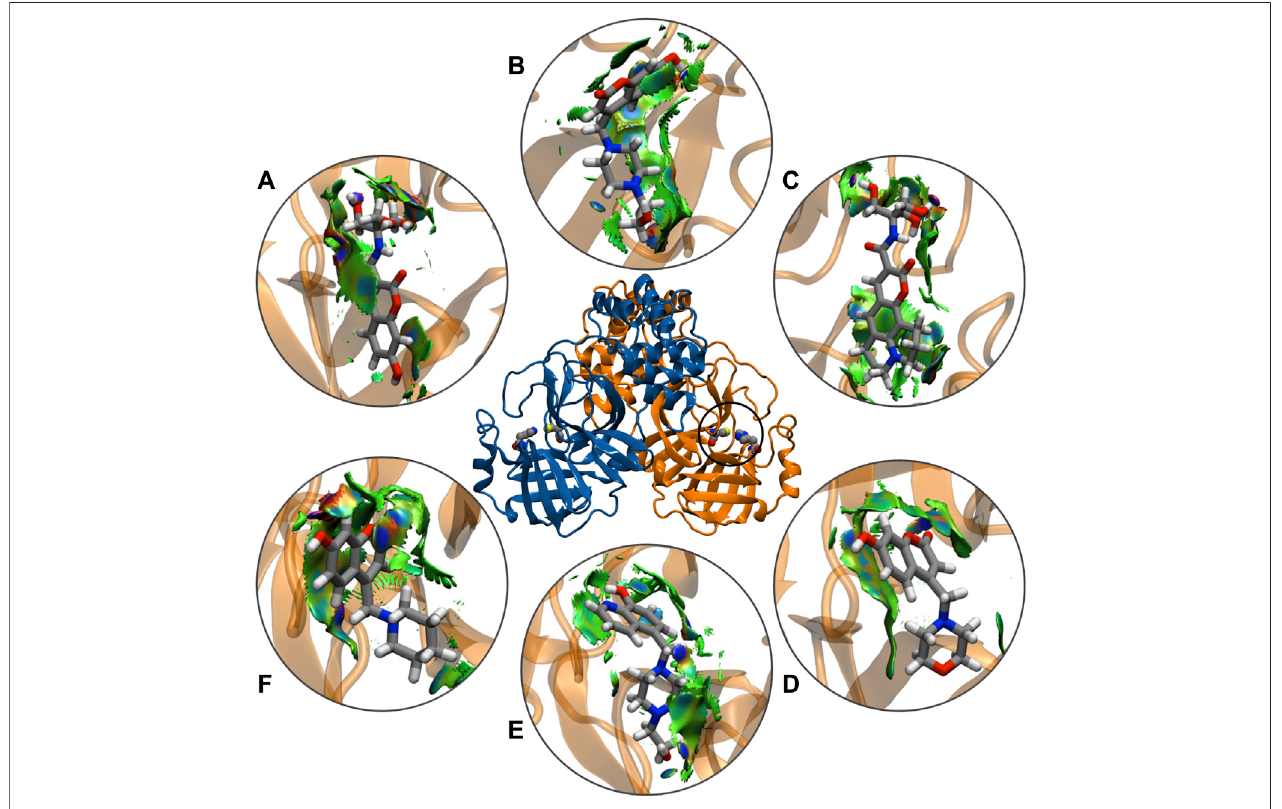
FIGURE 8 | Schematic representations of main component analysis of their respective production run for NCIPLOT isosurface gradient (0.6 au) of ligands (A) CTR9, (B) 7HC6, (C) CTR6, (D) 7HC3, (E) 8HQ6 and (F) 7HC5 on the structure of SARS-CoV-2 M pro . The color scale is − 2.0 < ρ < 2.0 au.